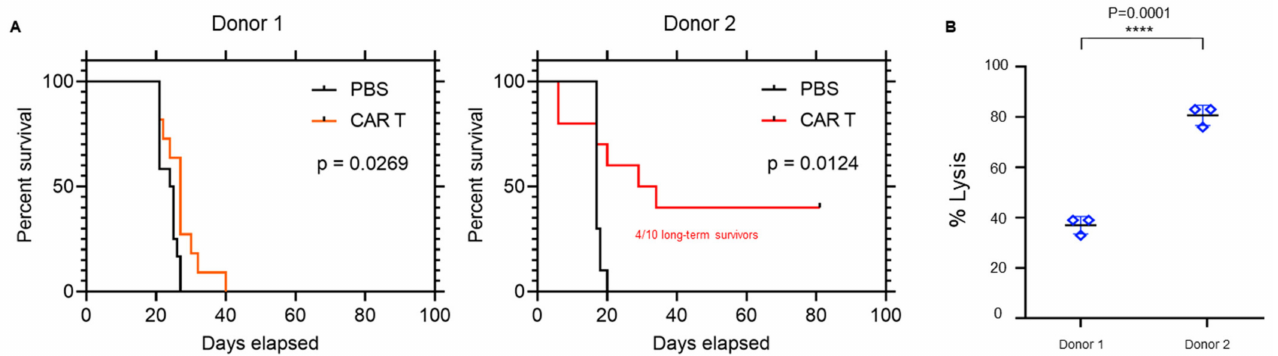
Figure 2. Donor differences in CAR activity and trogocytosis. ( A ) Representative survival curves of mice bearing U87-EGFRvIII tumors treated with EGFRvIII CARs engineered from Donor 1 and Donor 2 (n = 10/group). ( B ) Target tumor cell (U87-EGFRvIII) lysis following co-culture with EGFRvIII CARs (E:T 5:1) from Donors 1 and 2 for 24 h. **** p = 0.0001.